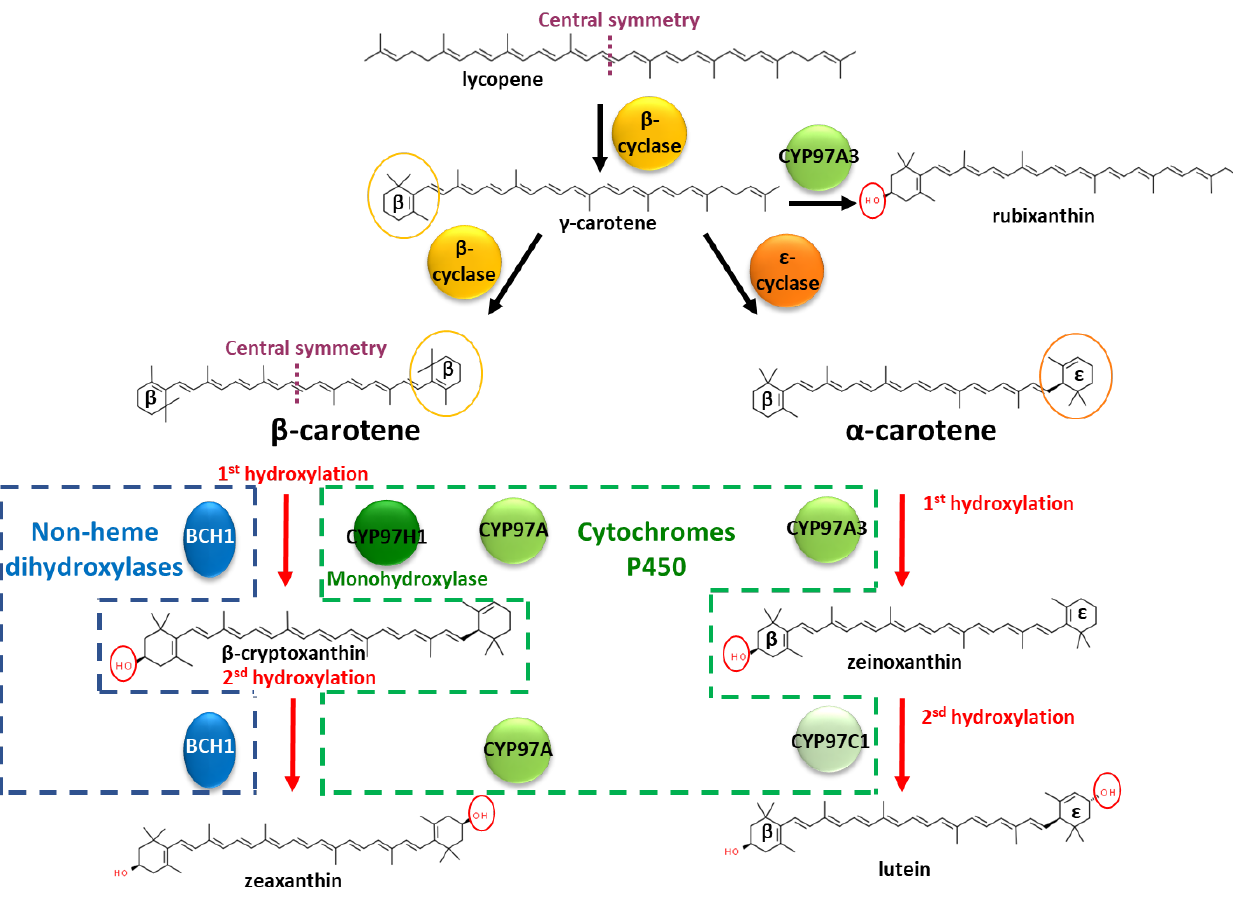
Figure 1. Hydroxylations in the β -carotene and α -carotene pathways with characterised mono- and dihydroxylases. β -cyclase and ε -cyclase refer to lycopene cyclase, leading to β or ε cyclisation, respectively. BCH1 refers to Bacterial Carotene Hydroxylase 1 from A. thaliana . CYP97A refers to the cytochrome P450 97 family, clan A. CYP97H1 originates from E. gracilis ; CYP97A3 and CYP97C1 originate from A. thaliana